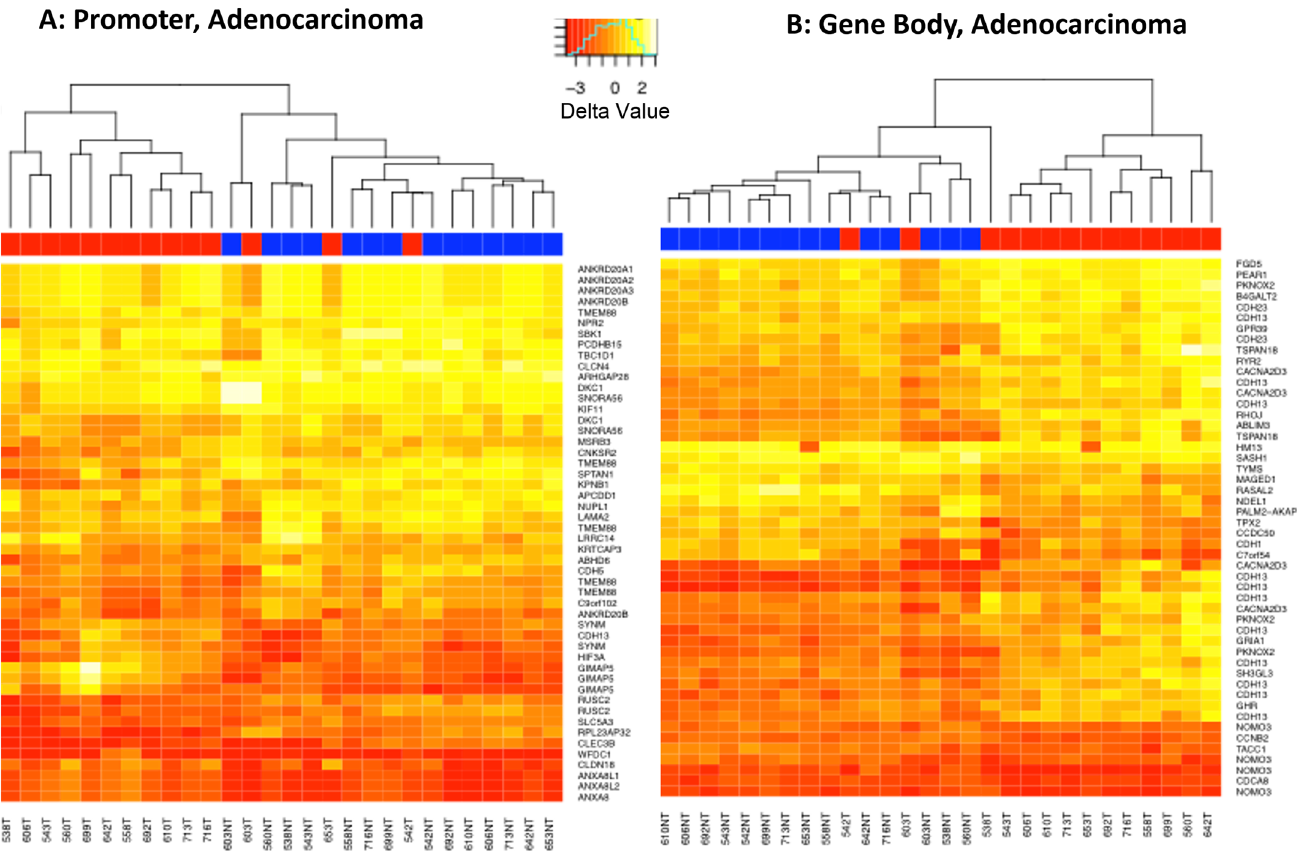
Fig 3. Heat Map of the Top 50 DM Loci within Adenocarcinomas. (A) Promoter regions; and (B) Gene body regions. Several genes show differential methylation (DM) at more than one locus and appear multiple times in the heatmap. Blue = Non Tumor, Red = Tumor.